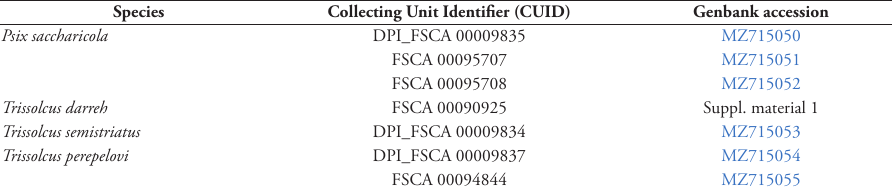
Table 1. Results of COI barcoding.